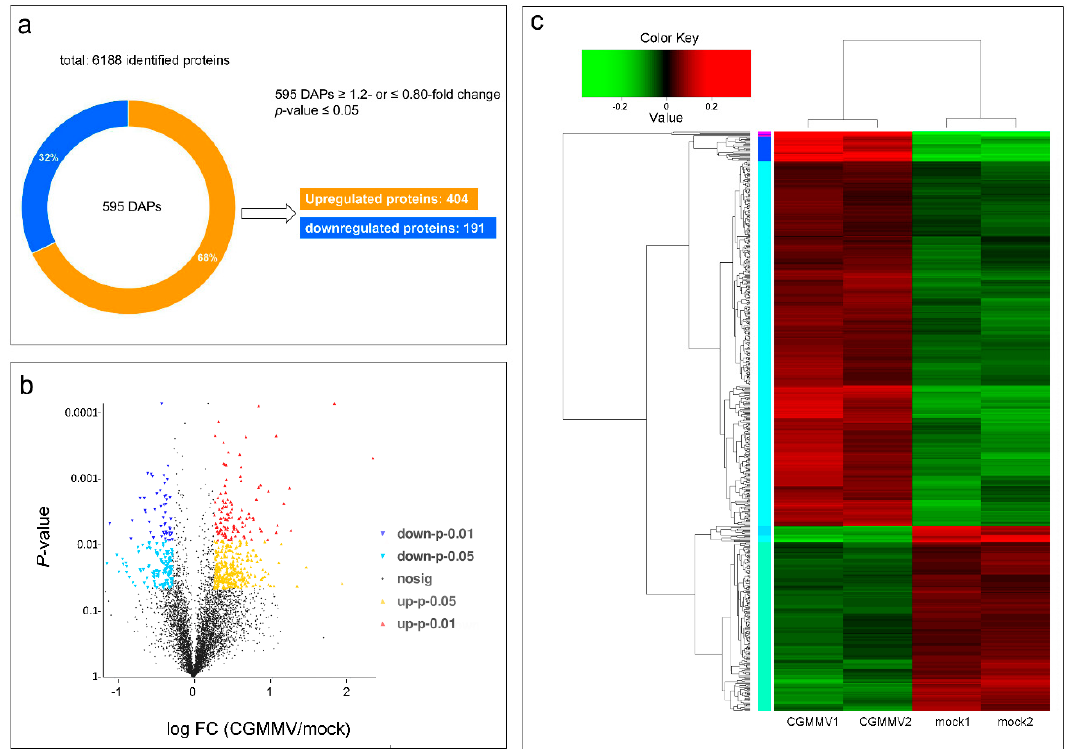
Figure 2. CGMMV-induced differentially accumulated proteins (DAPs) in watermelon fruits. ( a ) Overview of total identified DAPs, ( b ) volcano diagram of the distribution of DAPs. More upregulated proteins (red and yellow dots) were found than downregulated proteins (blue dots). ( c ) Hierarchical cluster of DAPs. CGMMV1 and CGMMV2 were two biological repeats as well as mock1 and mock2. The color from green to red represents protein accumulation level from low to high.